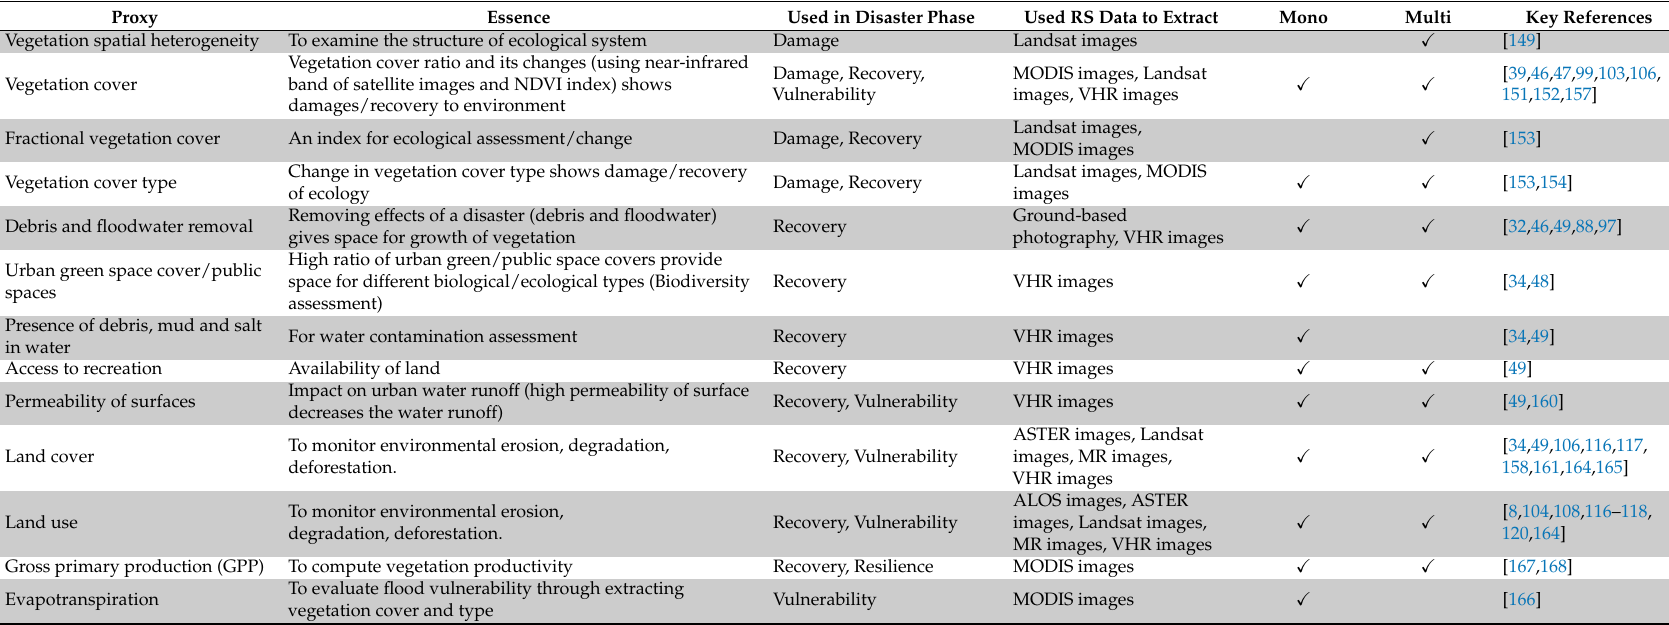
Table 8. Remote sensing-based proxies for the natural environment of urban DRM. Mono and Multi refer to mono-temporal and multi-temporal RS data that used for extraction,